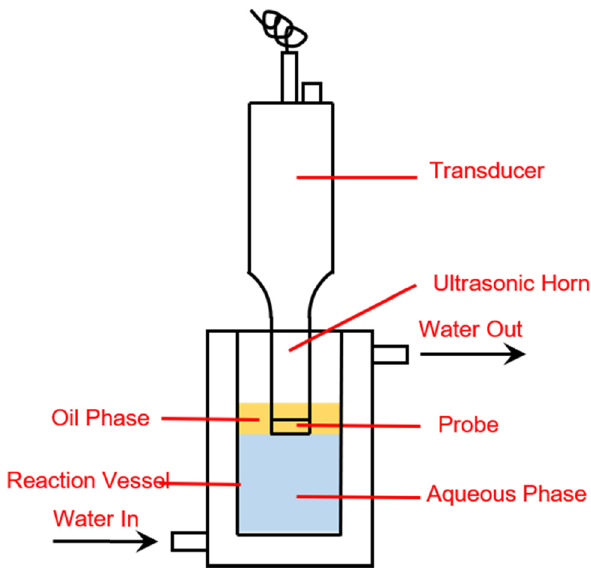
Figure 1: Schematic diagram of the experimental device for micro - capsules